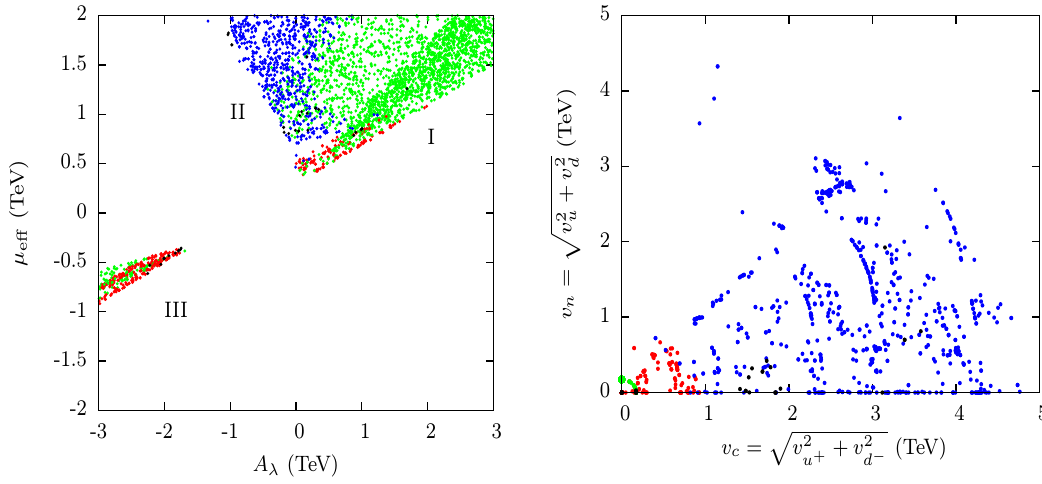
Figure 8 . Scatter plots showing stability status of the DSB vacuum in the A (cid:21) - (cid:22) e(cid:11) plane (left) and in the v c - v n plane (right). Color code employed is as for (cid:12)gure 7. Ranges of various NMSSM parameters that are randomly scanned over are j (cid:22) e(cid:11) j < 2 TeV, j (cid:20) j < 0 : 75 and j A (cid:21) j < 3 TeV while the (cid:12)xed NMSSM parameters are (cid:21) = 0 : 7, tan (cid:12) = 2, m